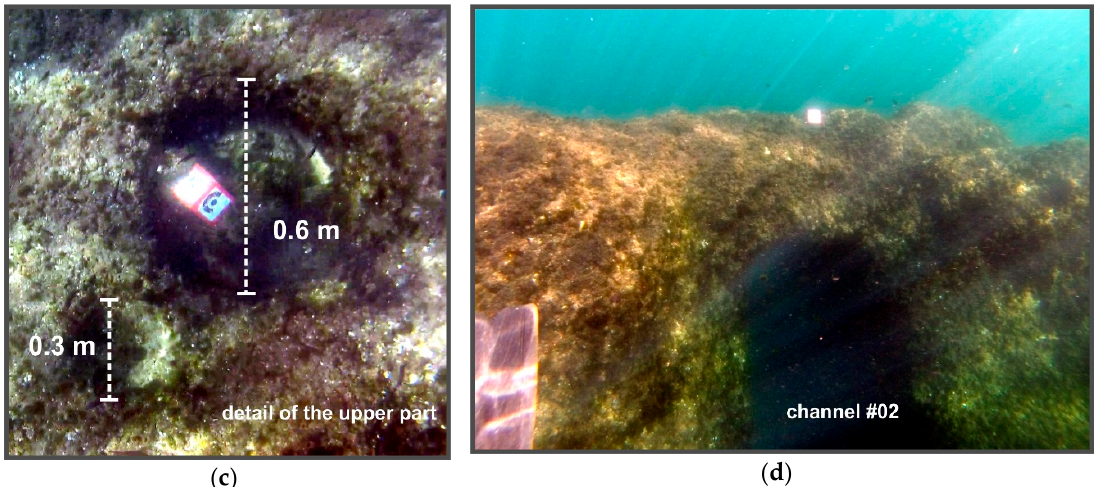
Figure 12. ( a ) NW zoomed sector of the map of the SSS mosaic; ( b ) underwater photo of channel #01; ( c ) underwater photo of circular holes located on the top of the archaeological structure; ( d ) underwater photo of channel #02.